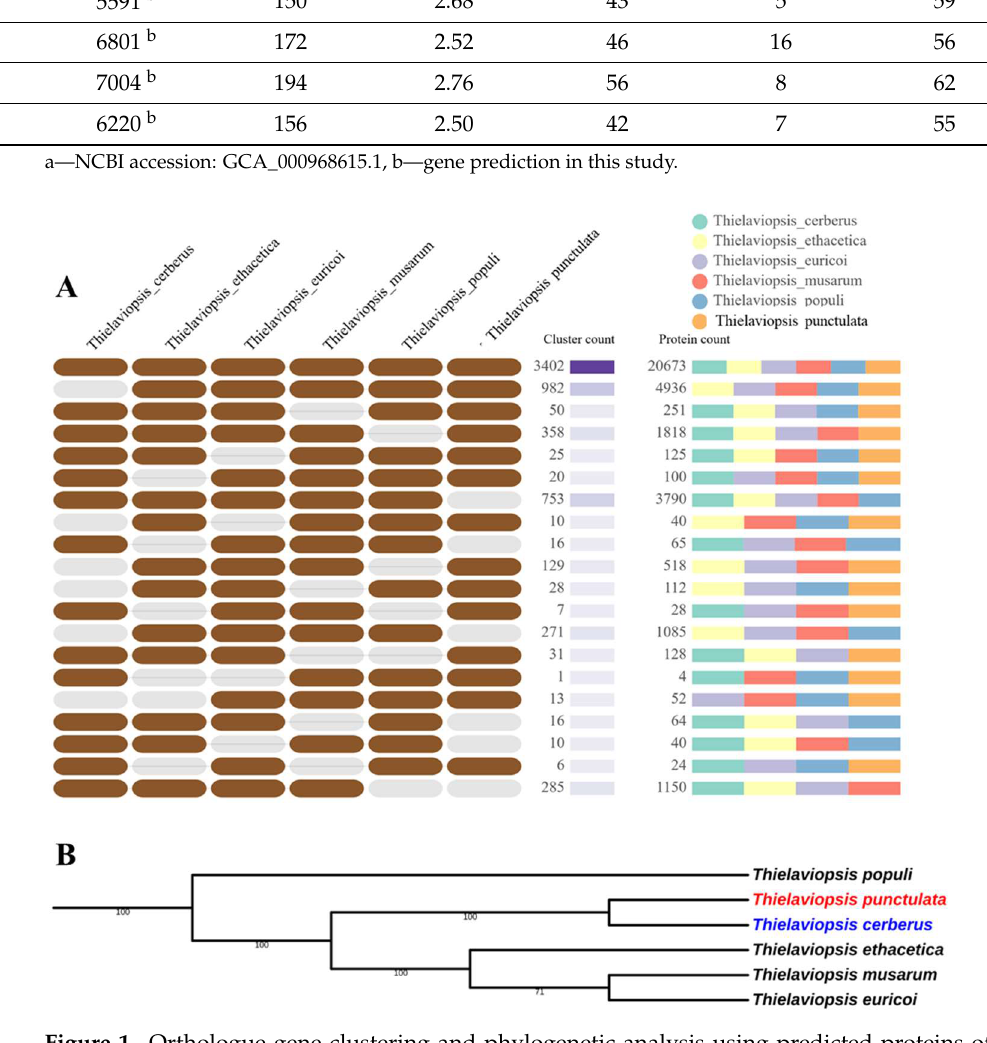
Figure 1. Orthologue gene clustering and phylogenetic analysis using predicted proteins of six Thielaviopsis species. ( A ). Orthologue clusters. Orthologue gene clusters were identified and visualized using the OrthoVenn2 web platform. The e-value cut off 1 × 10 − 10 was used for the analysis. ( B ). Phylogenetic tree of six Thielaviopsis species ( T. populi, T. ethacetica, T. cerberus, T. euricoi, T. musarum , and T. punctulata ) inferred from concatenated alignment of 50 shared orthologue proteins. The relationship was constructed by MEGA11 using the Maximum Likelihood method and JTT matrix-based model (based on 1000 bootstrap replications). The percentage of replicate trees in which the associated taxa clustered together in the bootstrap test are shown next to the branches. Table 1. Overview of Secretome of T. punctulata and its closely related species.